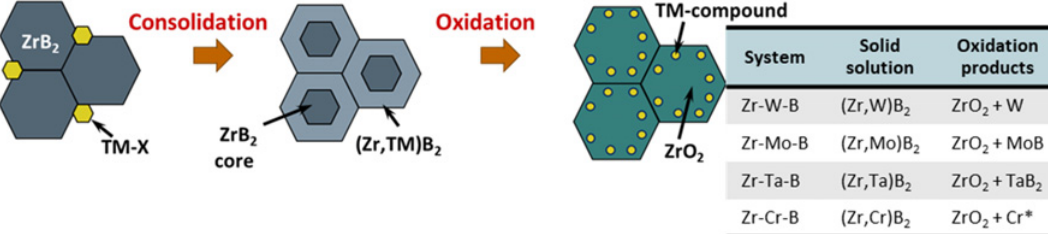
Fig. 1 Sketch of core–shell structure development in ZrB 2 ceramics in presence of a transition metal compound (TM-X) upon consolidation and evolution upon oxidation with the different products experimentally observed or predicted (*) depending on the TM